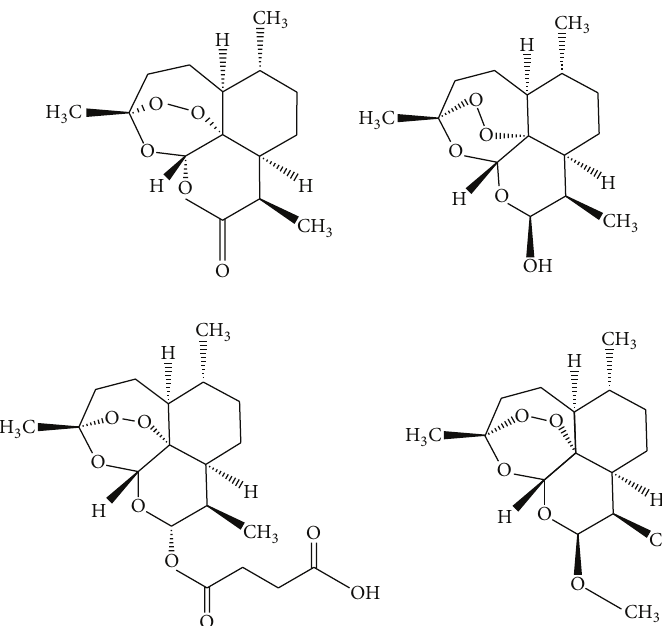
Figure 2: Artemisinin, dihydroartemisinin, artesunate, and artemether.